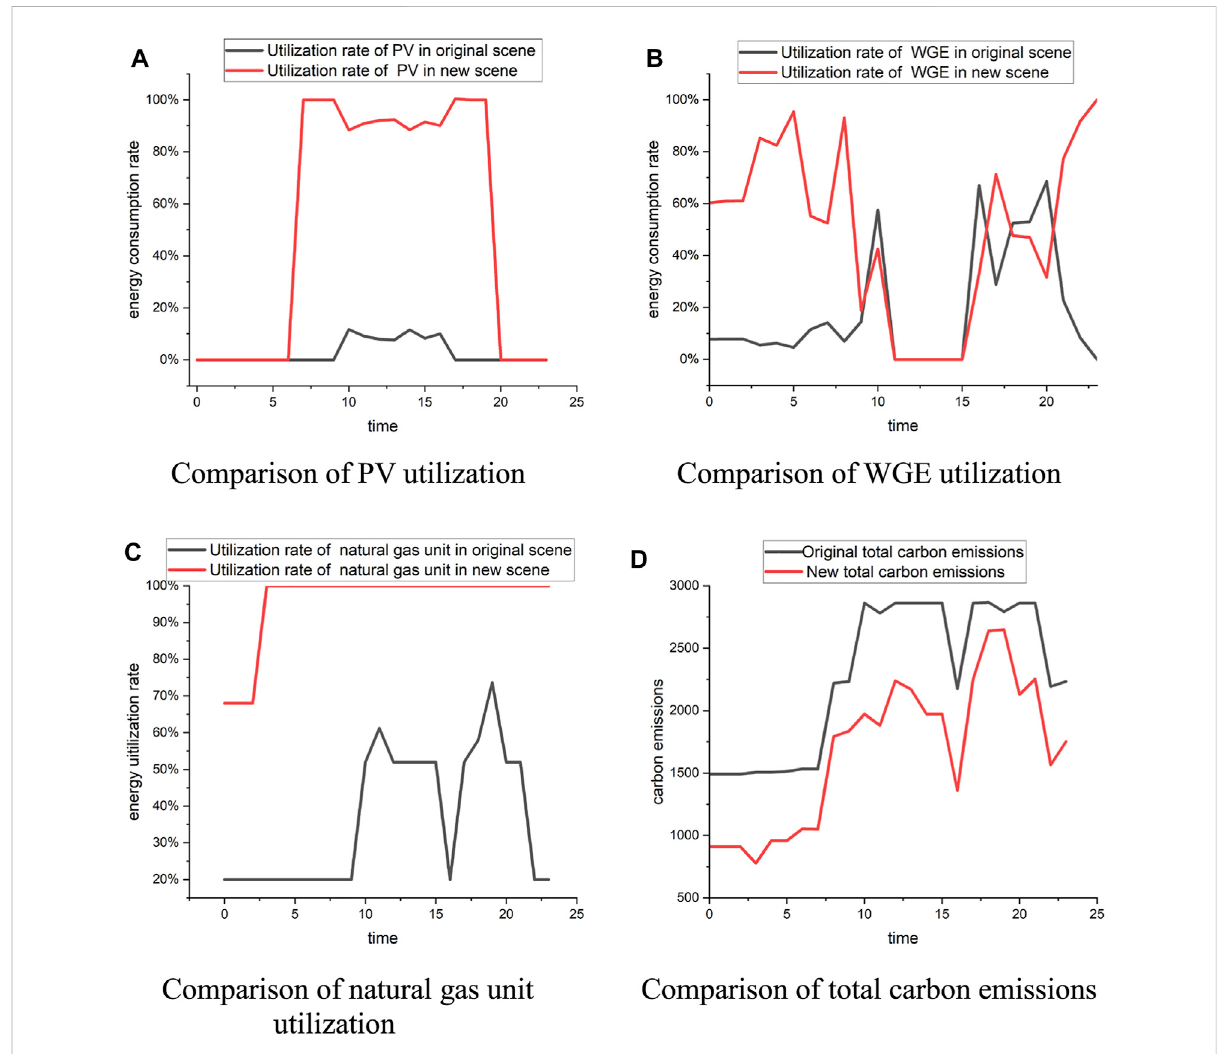
FIGURE 11 Parameters after considering carbon attributes and the initial market. (A) Comparison of PV utilization. (B) Comparison of WGE utilization. (C) Comparison of natural gas unit utilization. (D) Comparison of total carbon